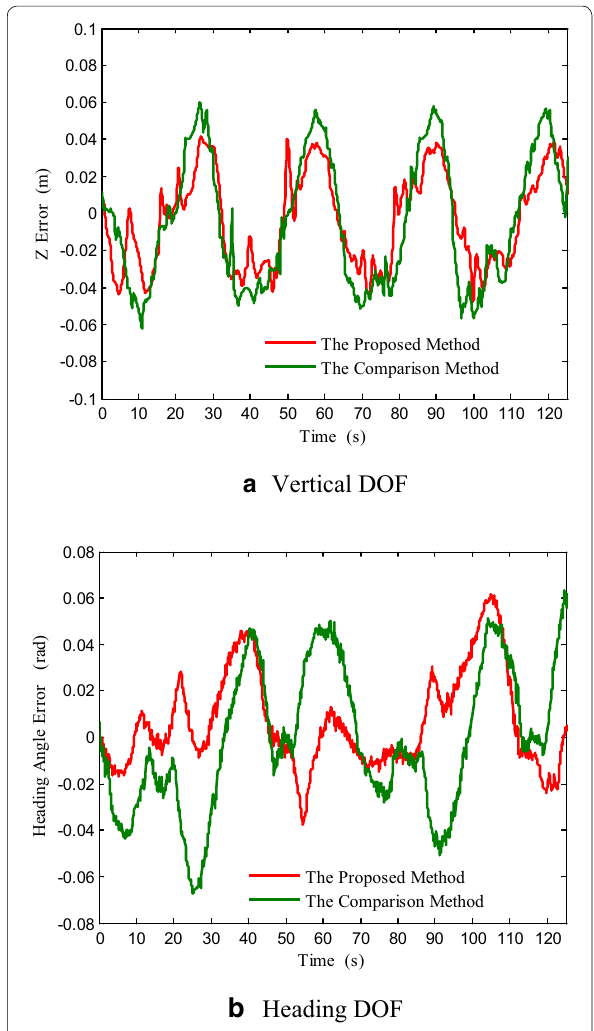
Figure 11 Tracking error in 0.3 m/s ocean current environment